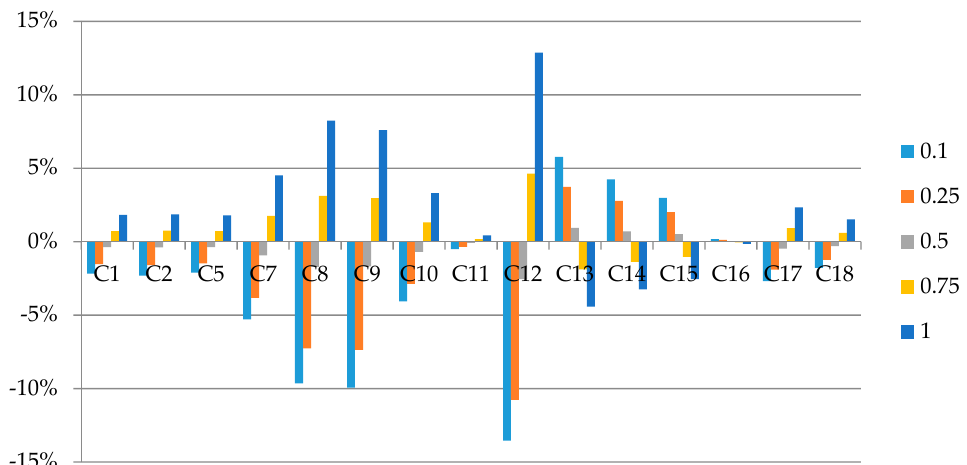
Figure 6. The effect of the factor “policy and regulation”.